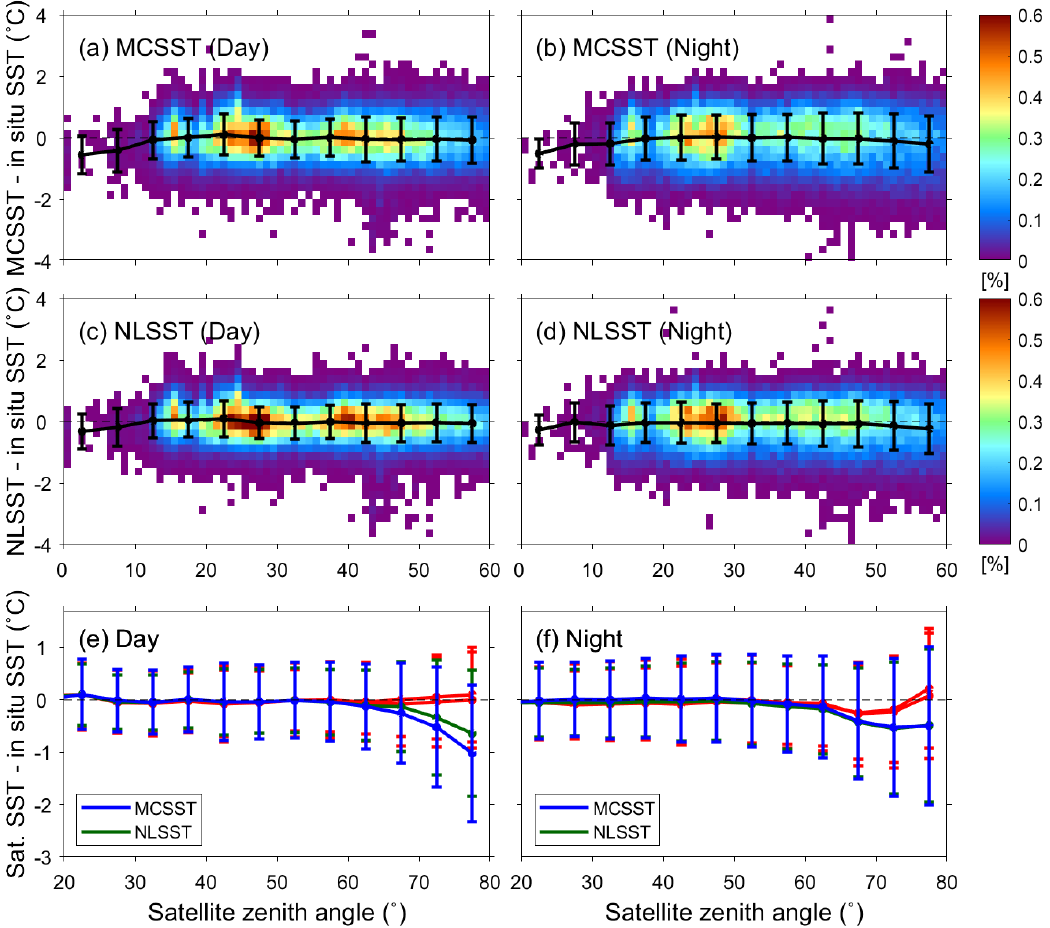
Figure 8. Distributions of MCSST errors during the ( a ) daytime and ( b ) nighttime and NLSST errors during the ( c ) daytime and ( d ) nighttime as a function of satellite zenith angle (SZA) in range of 0 ◦ –60 ◦ and mean bias and standard deviation of SST errors (blue and green) of each interval during the ( e ) daytime and ( f ) nighttime with respect to SZA in range of 20 ◦ –80 ◦ , where the red bars represent SST errors in case of SZA correction term ( sec ( θ ) − 1) included in the SST equations. To investigate the SZA effect on the SST errors, we included all the matchups for an SZA range below than 80 in the regression procedure. Figure 8 shows the SST errors as a function of the SZA values from 20° to 80° for MCSST and NLSST as marked in green and blue. In the daytime, the mean errors of MCSSTs were larger than those of NLSSTs, as indicated in Figure 8e. However, the reduction effect of NLSST errors disappeared when the same errors for a range of SZA less than 60° in the